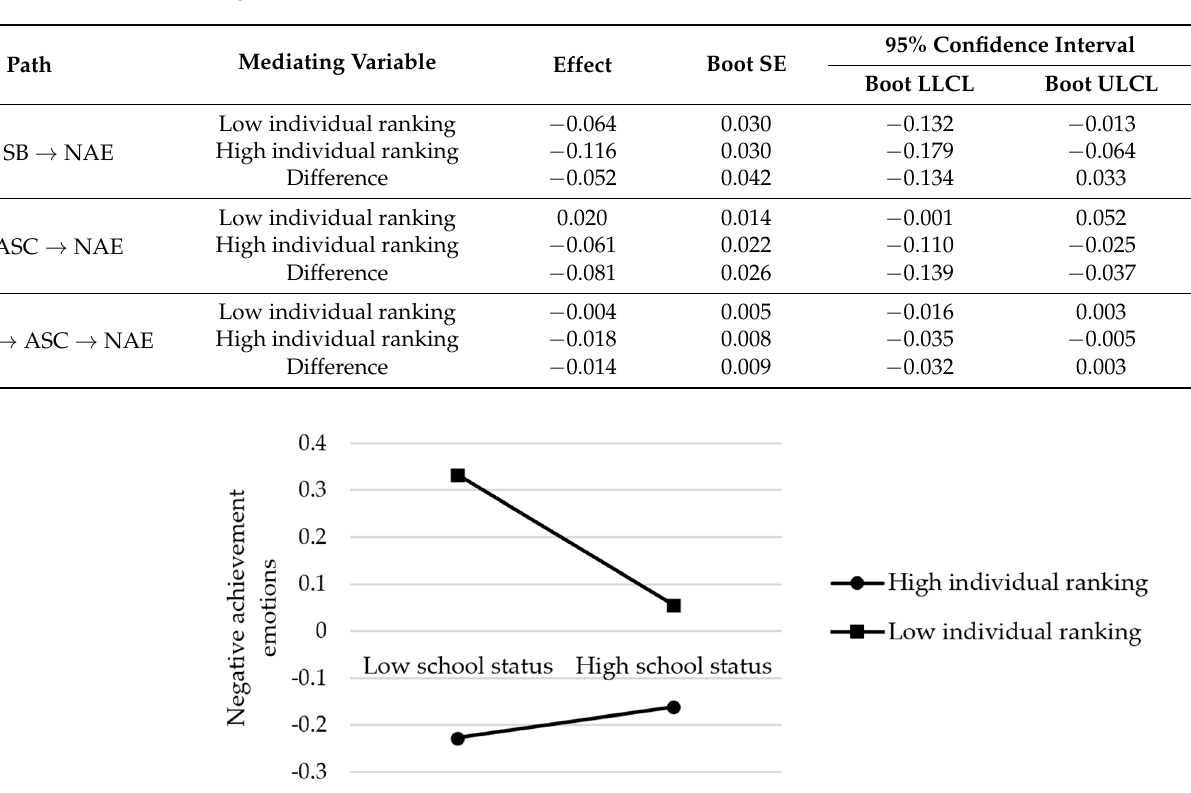
Figure 6. The diagram of the moderating effect of individual ranking on the path from school status to negative achievement emotions.